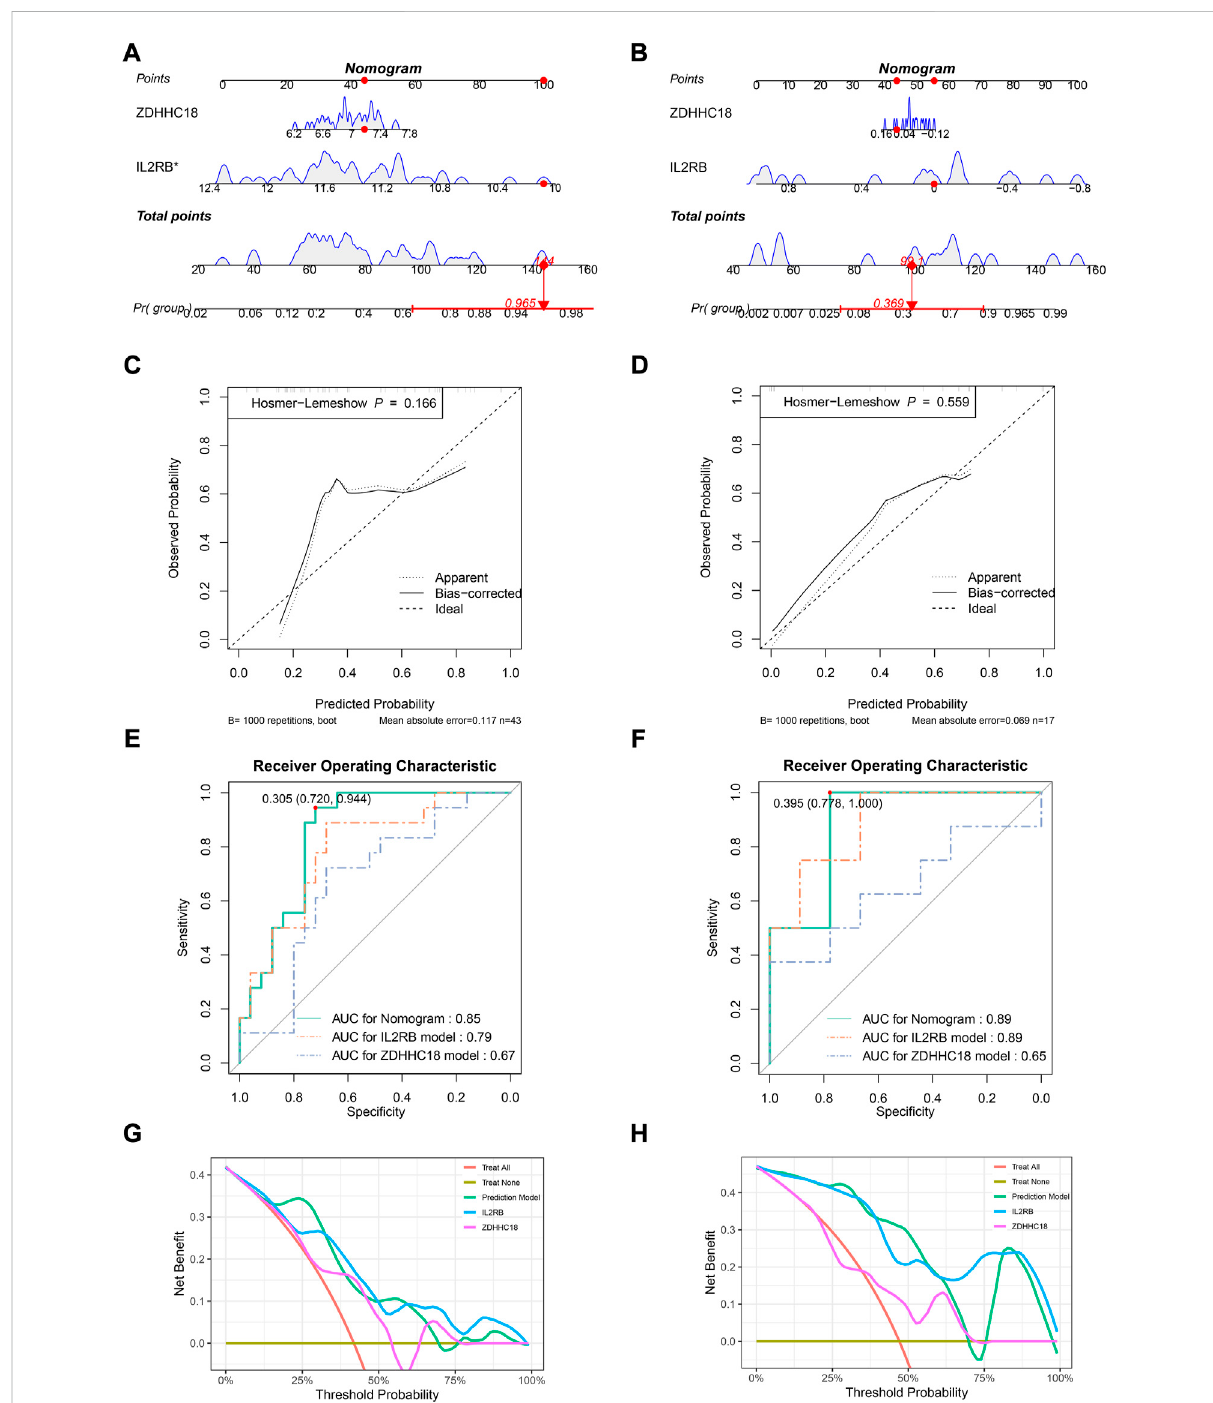
FIGURE 3 Validating thediagnosticmodelinvalidationsets. Nomograms forthediagnosticmodelinGSE18781 (A) andGSE11886 (B) . Calibrationplots for the diagnostic model in GSE18781 (C) and GSE11886 (D) : the x -axis represents the predicted probability of AS by the model, while the y -axis represents the observed probability of AS. The diagonal (dashed line) represents the ideal status that the predicted probability equaled the observed probability, and the solid and dotted lines represent the apparent and bias-corrected statuses of the predicted and observed probabilities, respectively. ROC plots for the diagnostic model in GSE18781 (E) and GSE11886 (F) : the x -axis represents 1-speci fi city of the model, while the y -axis represents the sensitivity of the model. DCA in GSE18781 (G) and GSE11886 (H) : the x -axis represents the threshold probability of the treatment or intervention, while the y -axis represents the net bene fi